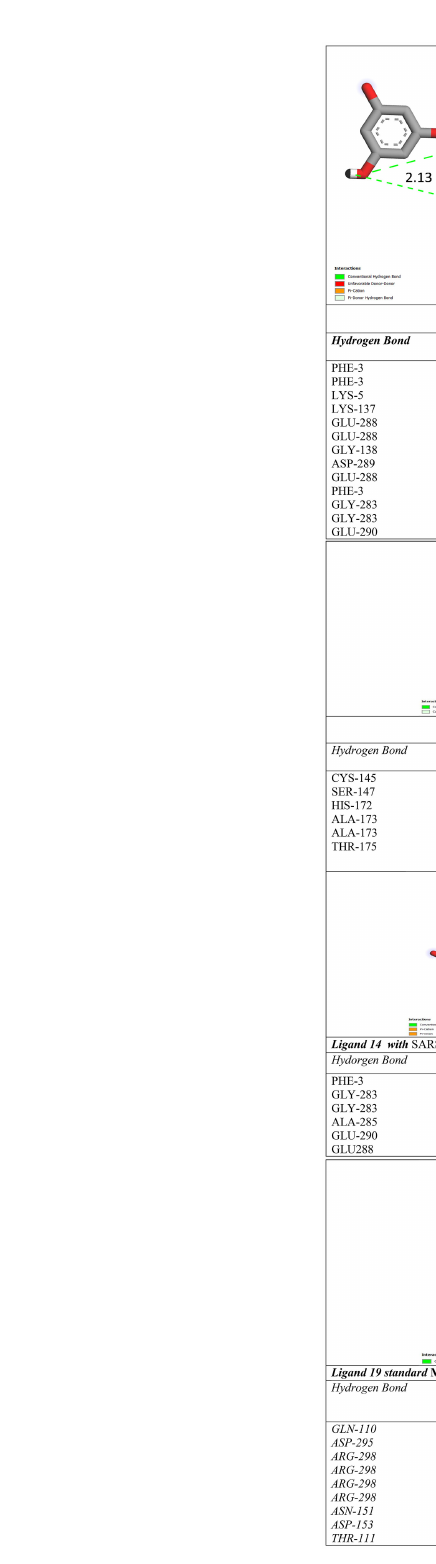
FIGURE 6 Protein-ligand interaction and their active sides based on High binding